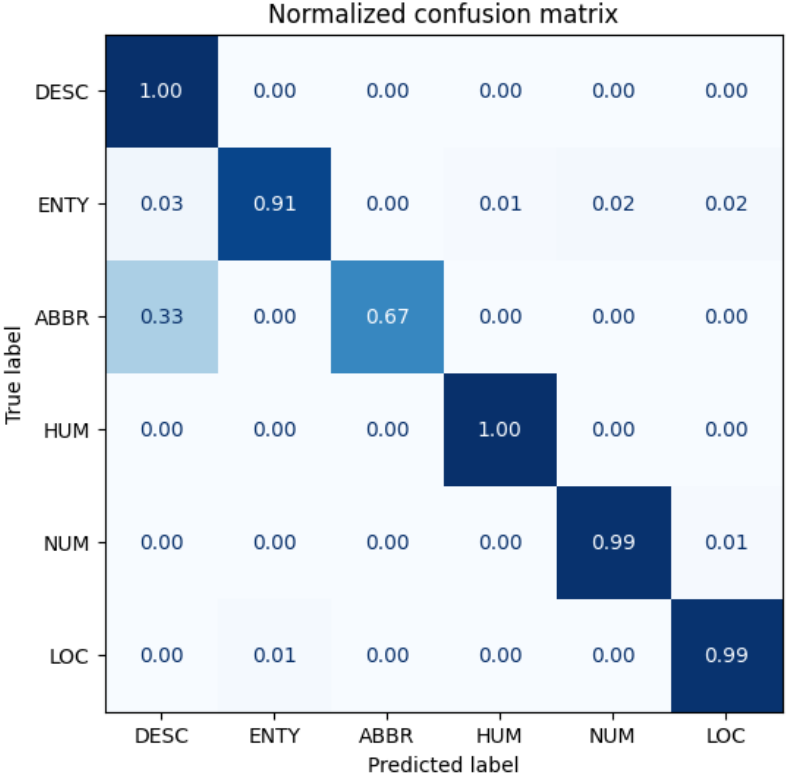
Figure 16. Antonym2 Run1 Confusion Matrix on